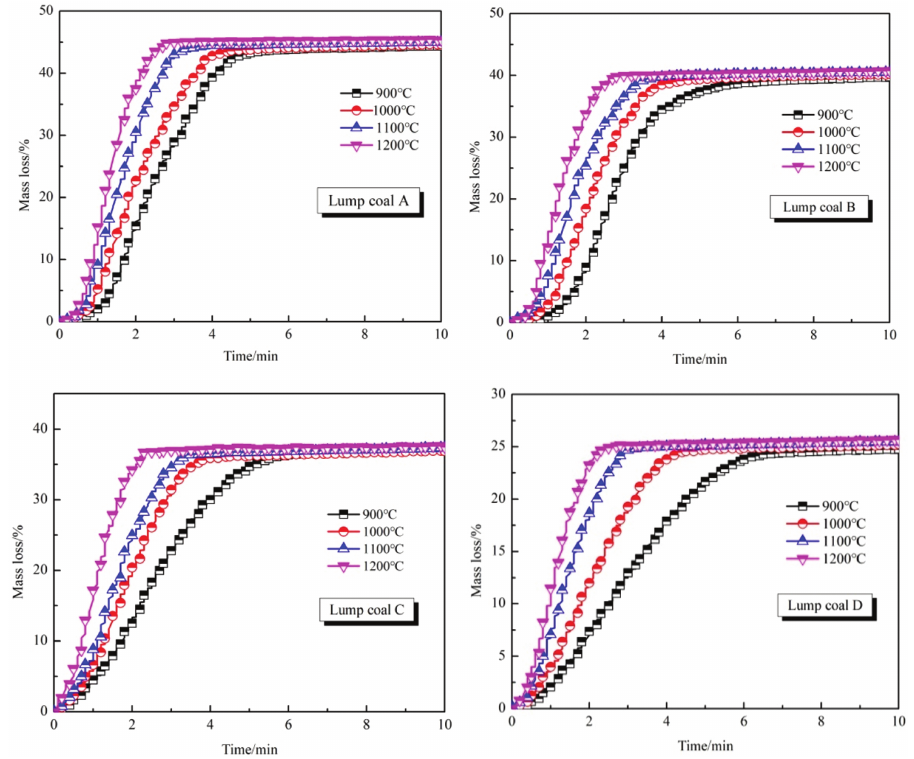
Figure 4: Mass loss of lump coals at different